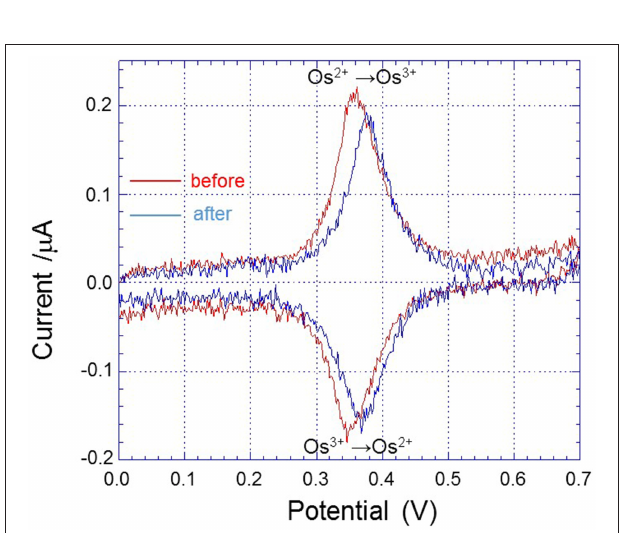
FIGURE 6 | Amperometric response of addition of PMA dissolved in DMSO (0.001%) in system without THP-1 cells on oxygen reduction current (red trace) measured using WE1 and reduction current for H 2 O 2 (blue trace) measured using WE2. PMA at final concentration of 200 nM was added after 5 min of start of measurement (indicated by